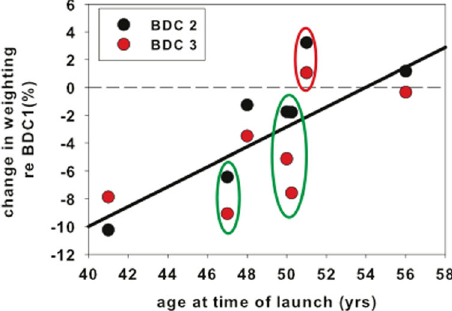
Fig. 7 The change in visual weighting (relative to BDC1) is plotted as a function of age-at-launch for BDC2 and BDC3 data. Positive changes correspond to an increase in visual weighting. The regression line though the data has an r 2 of 0.55. The data circled in red are from astronaut E who had 193 days of space experience prior to launch, and the data circled in green are from astronauts with no prior space